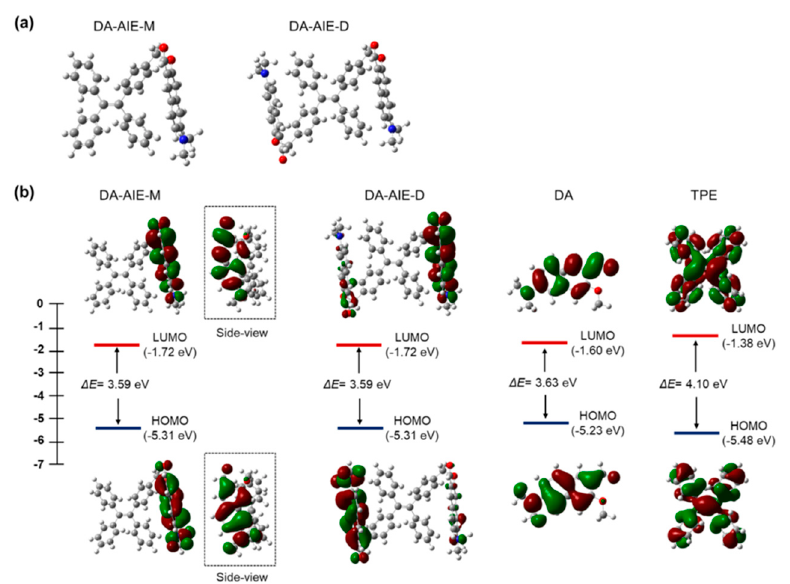
Figure 5. Quantum chemical calculations for DA-AIE-M, DA-AIE-D, DA, and TPE. ( a ) Optimized structures of DA-AIE-M, DA-AIE-D calculated using the DFT calculations. ( b ) The HOMO and LUMO orbitals and their energies for the compounds.